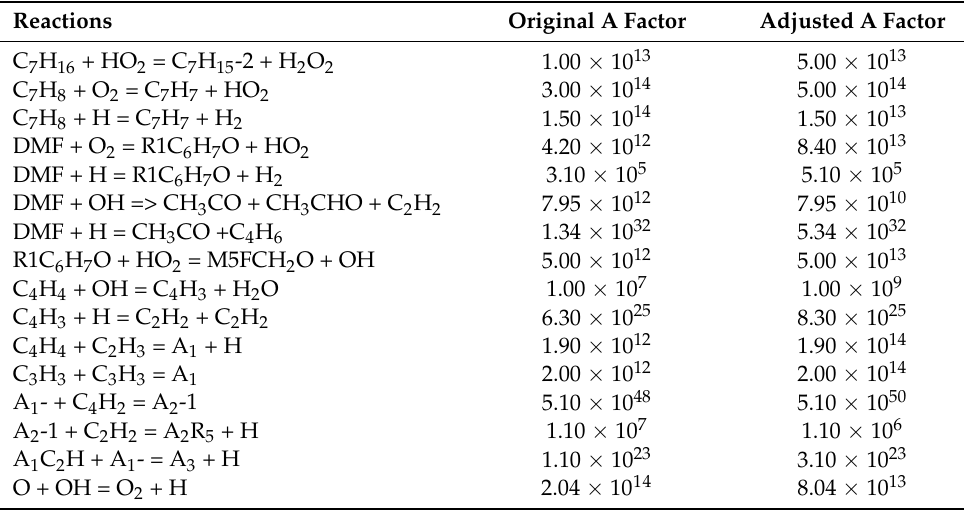
Table 2. Adjusted A factors for n-heptane/toluene/DMF-PAH